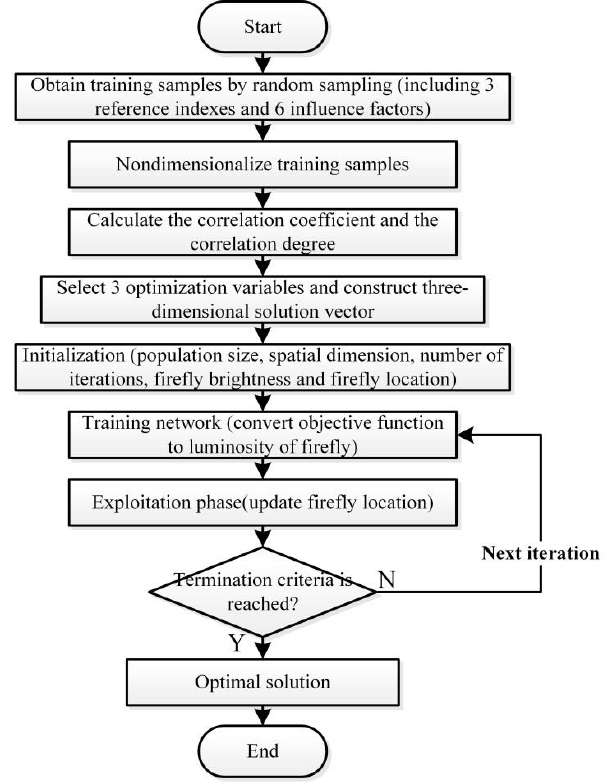
Figure 7. Grey relation analysis-firefly algorithm (GRA-FA) flowchart.